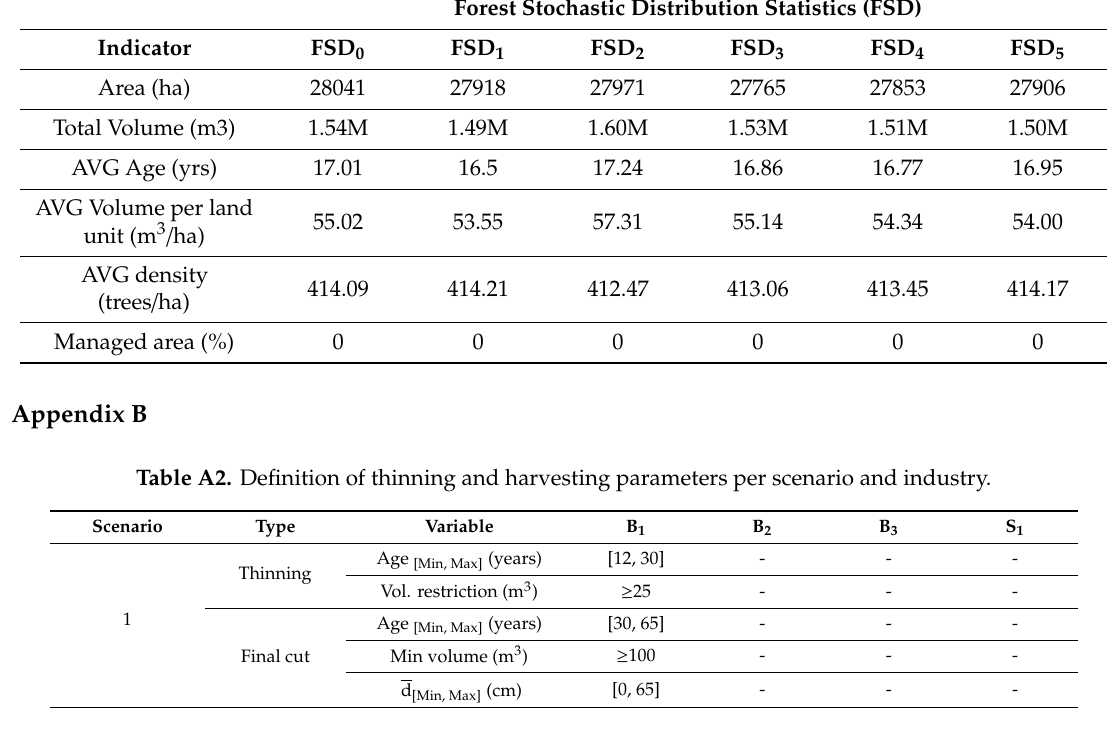
Table A1. Stochastic distributions used in the initialization process: the forest stochastic distribution FSD 0 was used to test all the scenarios with the initialized volumes goals; FSD1 to FSD5 were used to test the top four scenarios selected according to sustainability criteria.